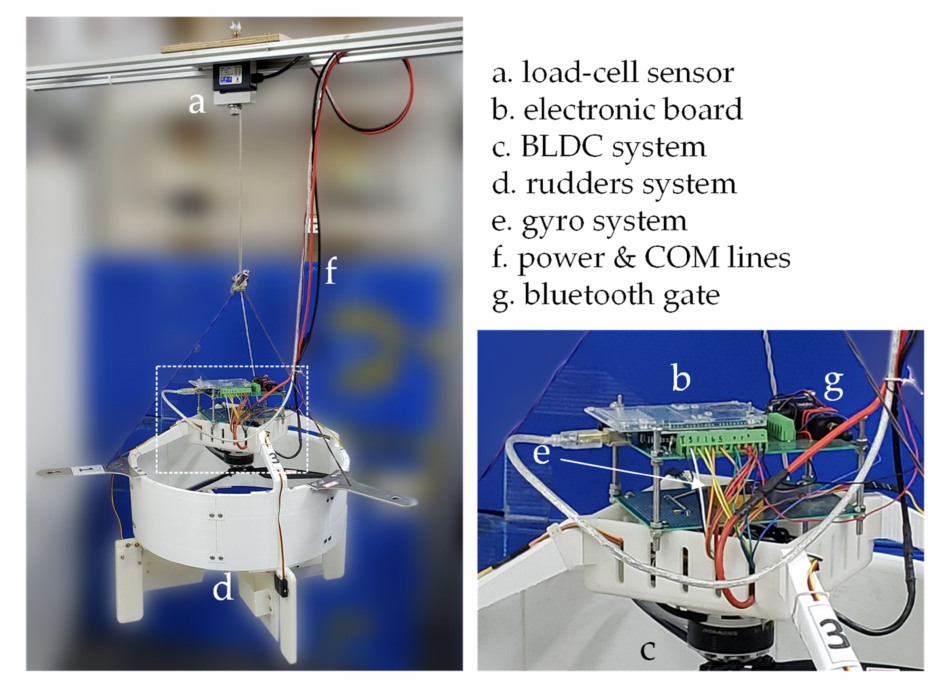
Figure 18. The experimental setup of the ducted fan unmanned aerial vehicle